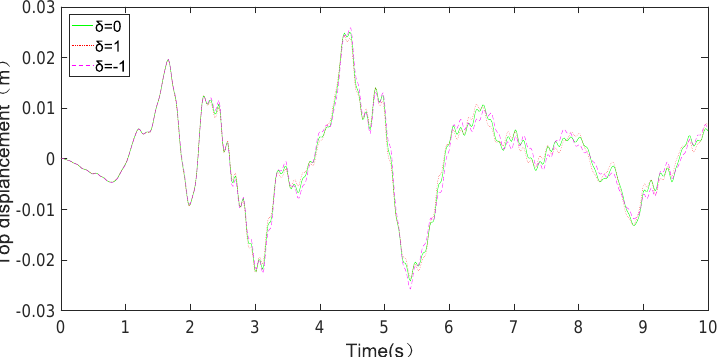
Figure 19. Top floor displacement curve of the uncertain structure under the El-Centro wave.